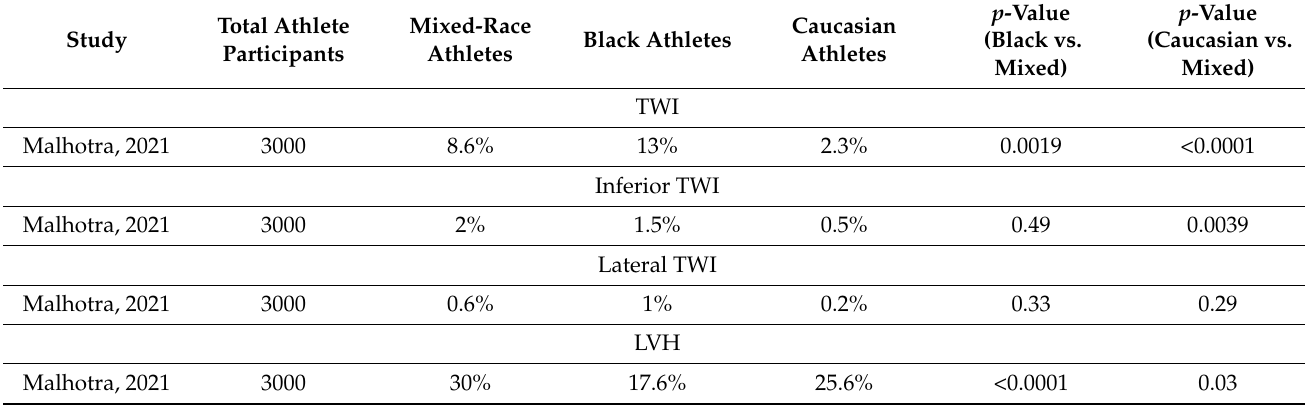
Table 5. Proportions of ECG changes in mixed-race athletes compared to others.